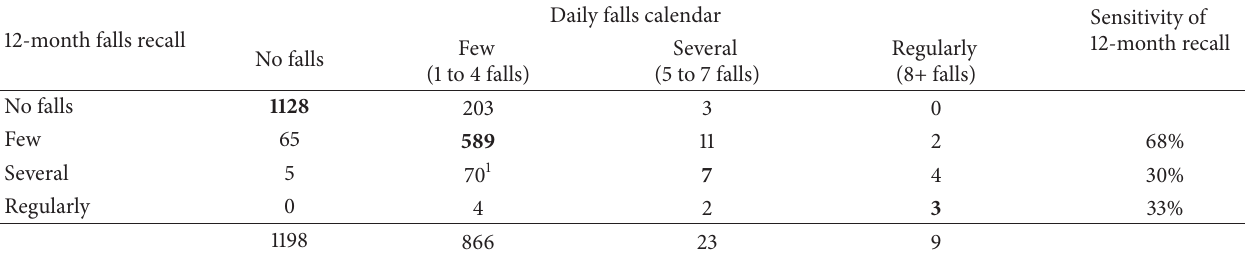
Table 3: Cross tabulation of falls by best agreement between monthly ascertainment and 12-month recall category